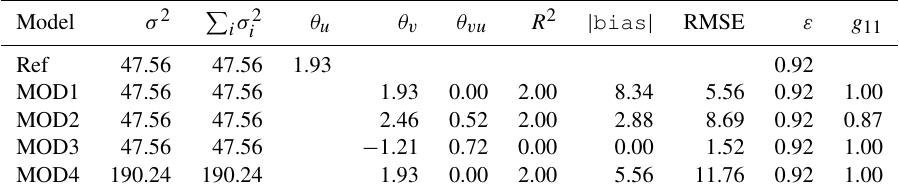
Table 1. Individual components of the error for the synthetic datasets used for the illustration of the methodology. σ 2 represents the total variance (m 2 s − 2 ) of every dataset as computed from the original zonal and meridional components. (cid:80) i σ 2 represents the variance (m 2 s − 2 ) i of wind for every dataset (reference or model) as computed from the EOF decomposition (axes of the ellipses in the diagrams). θ u and θ v represent the angles (radians) of the semi-major axes of the ellipses calculated for reference and models. θ vu (radians) represents the relative rotation of the semi-major axis of the model data with respect to the observations. R 2 represents the two-dimensional squared correlation coefficient (sum of the squared canonical correlations). | bias | represents the magnitude of the bias (ms − 1 ). RMSE lists the root mean squared errors (ms − 1 ). The eccentricity of the ellipses ( ε ) is the same for all the synthetic datasets because of the way they have been built. Finally, g 11 represents the congruence coefficient (Eq. 20) for EOF1 of all models with respect to EOF1 as derived from observations. Model σ 2 (cid:80) i σ 2